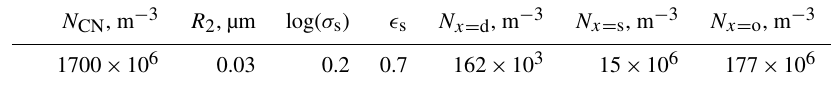
Table 2. Large-scale continental aerosol specification for cloud droplet nucleation and default parameters for ice